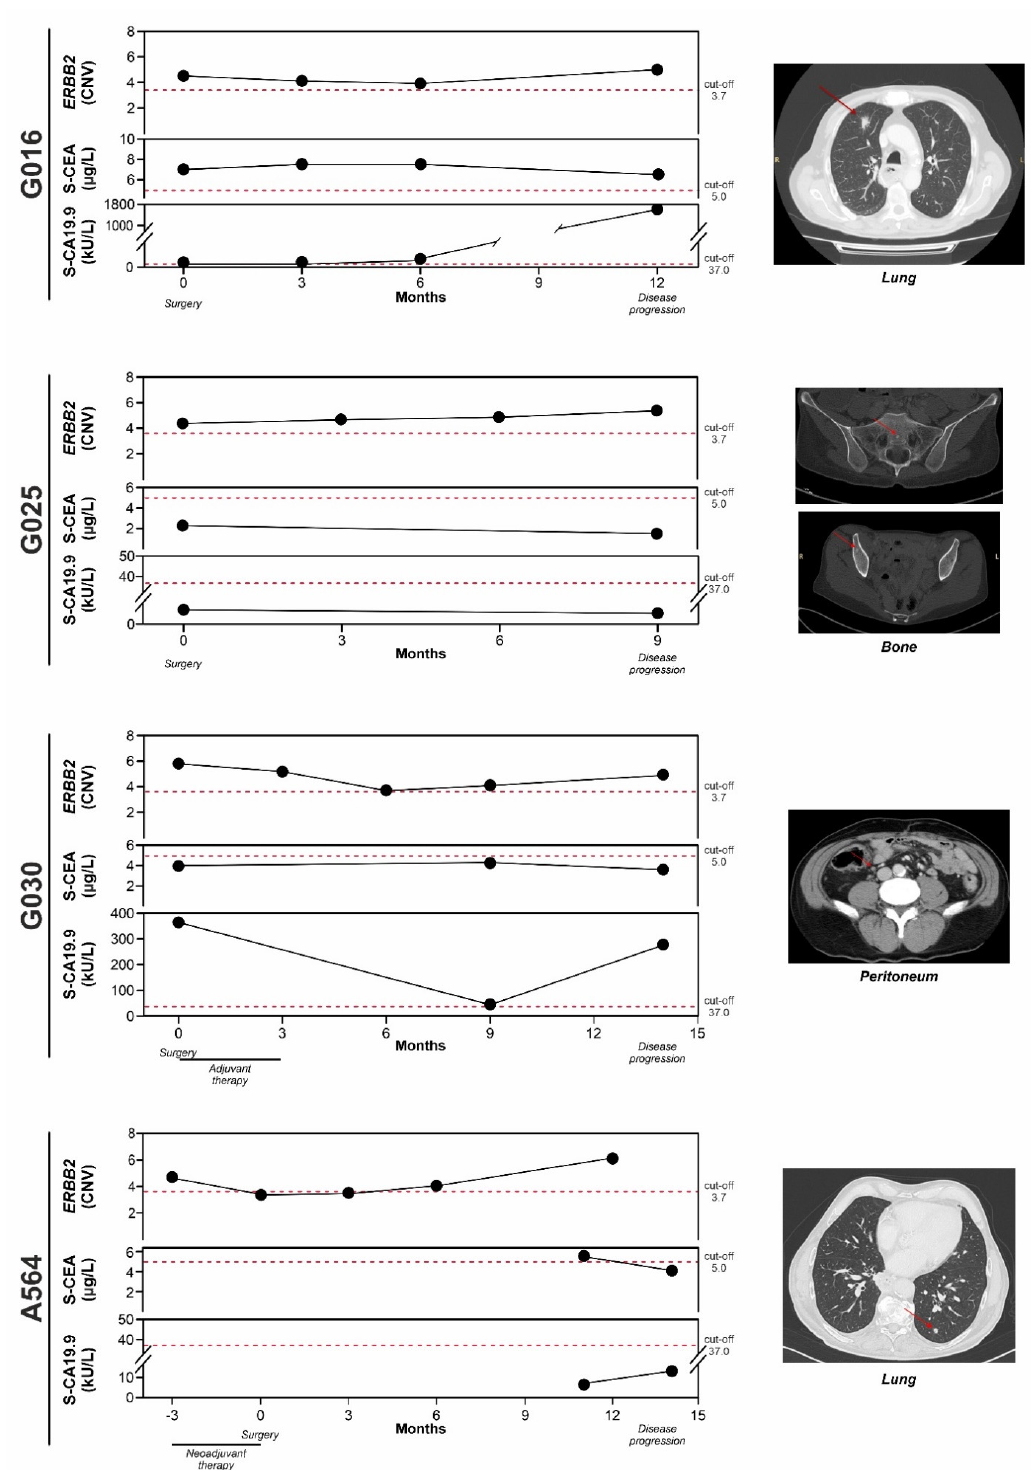
Figure 5. Longitudinal analysis of four “progressor” GEA patients (G016, G025, G030, and A564). ERBB2 CNV values and tumor markers S-CEA and S-CA19.9 are reported for each patient at different time points. The administration of neoadjuvant or adjuvant therapy, surgery, and the time of disease progression are indicated. A representative TAC image is shown on the right-hand side. A red arrow marks the site of metastasis. S-CEA, soluble carcinoembryonic antigen; S-CA19.9, soluble carbohydrate